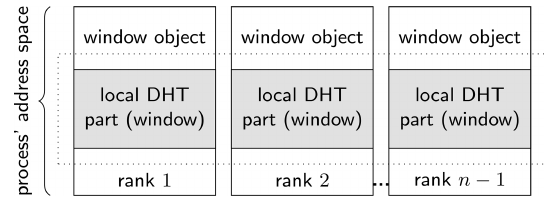
Figure 5. Usage of MPI windows for a distributed hash table.